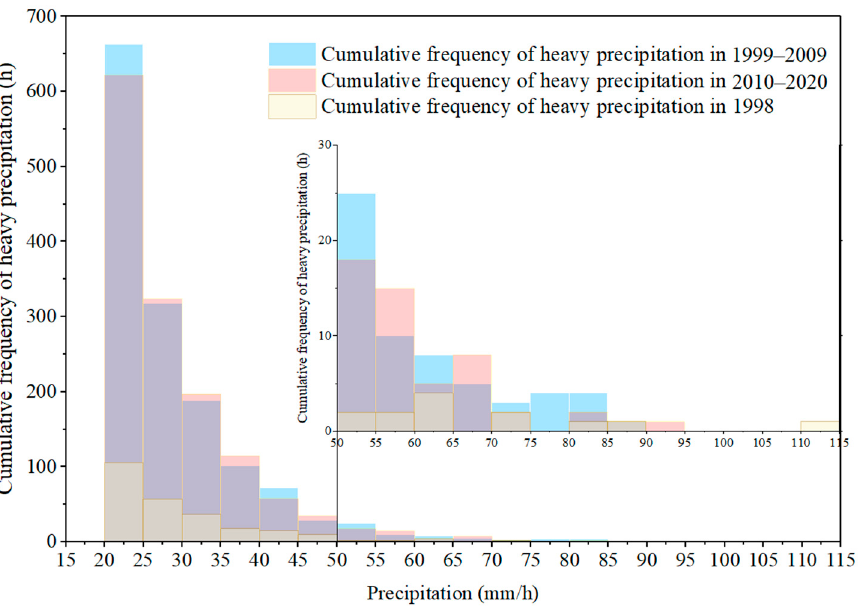
Figure 3. Vertical distribution of accumulative frequency of heavy precipitation in 1999–2009, 2010–2020 and 1998.